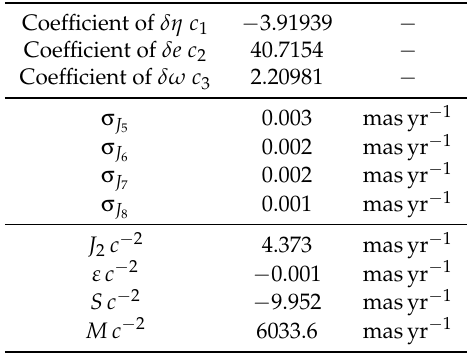
Table A8. Upper three rows: Numerical values of the coefficients c 1 , c 2 , c 3 of the linear combination of Equation (20) canceling out the classical precessions induced by the first three zonal harmonics J 2 , J 3 , J 4 for the orbital configuration of TableA6. Middle four rows: Uncancelled mismodeled precessions due to the zonal harmonics J 5 , J 6 , J 7 , J 8 , in masyr − 1 , linearly combined according to Equation (20); the formal, statistical errors σ J in J (cid:96) , (cid:96) = 5, 6, 7, 8 of the model Tongji-Grace02s [48], quoted in TableA1, were (cid:96) used. Lower four rows: pN precessions, in masyr − 1 , linearly combined according to Equation (20).